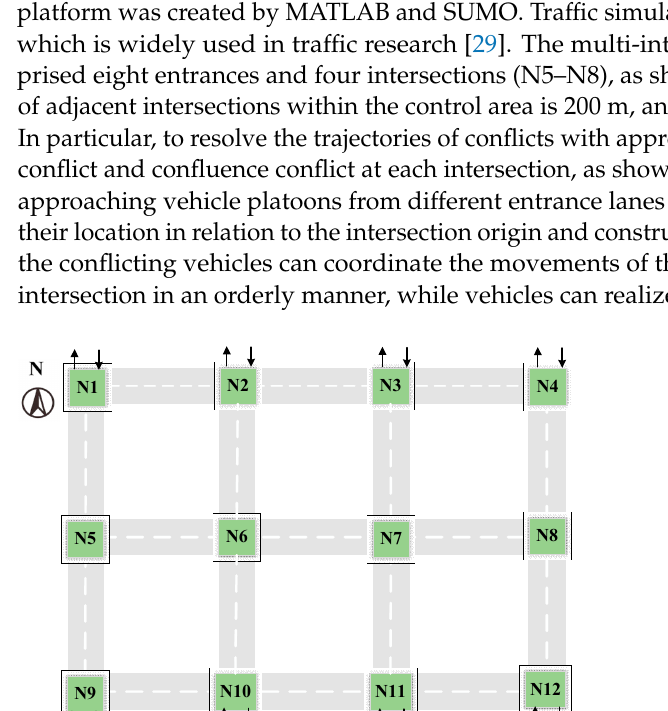
Figure 6. Virtual platoon projection. In this paper, the ICVs’ driving direction at each typical intersection was set as fol ‐ lows: 15% of the ICVs go straight, while 10% of the ICVs turn left. In this study, we set the time step as 0.1 T  